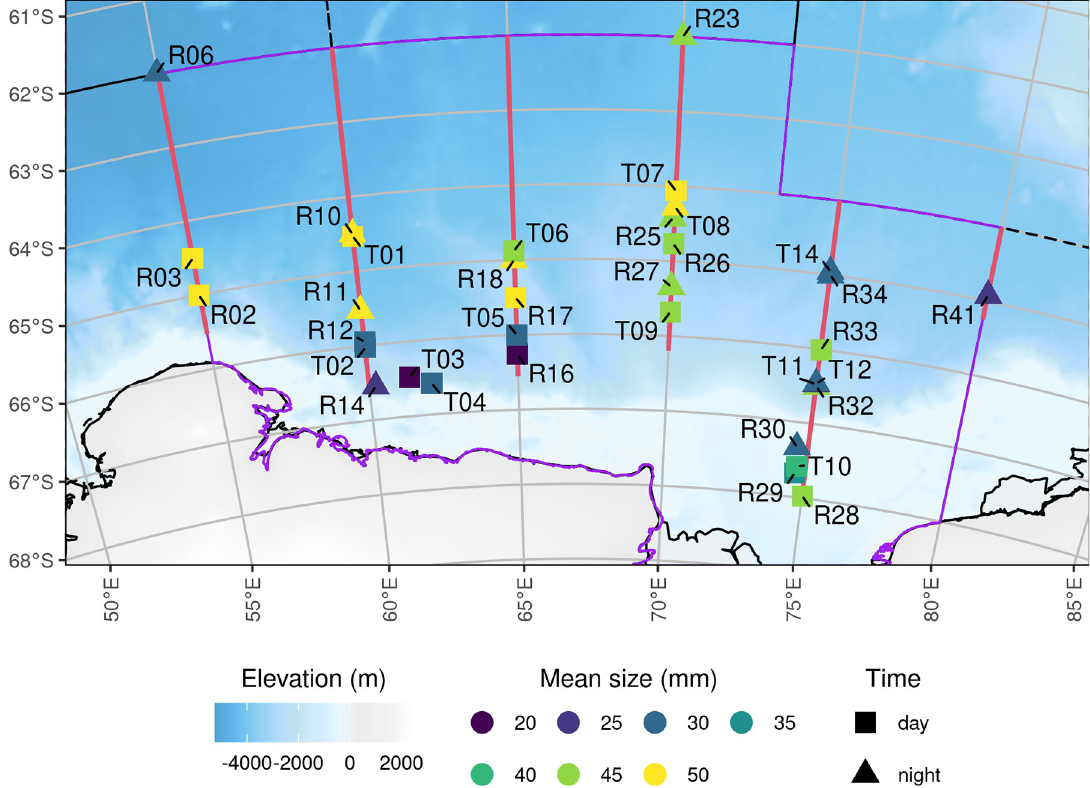
Fig 2. Net trawl locations where krill were sampled. Trawl type: routine or target are denoted by R and T respectively in the station identification code. Day and night sampling are denoted by square or triangle symbols and colour is the mean length of krill in trawl. The background bathymetry grid is from The GEBCO_2014 Grid, version 20150318,